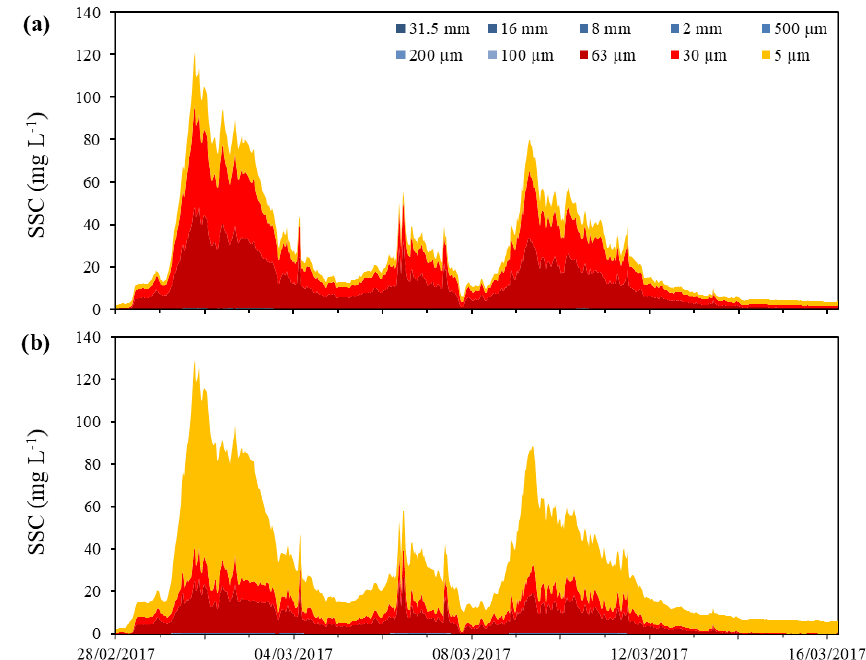
Figure 7. Downstream suspended sediment grain-size cumulative distribution simulated by model configurations (a) 10CL and (b)